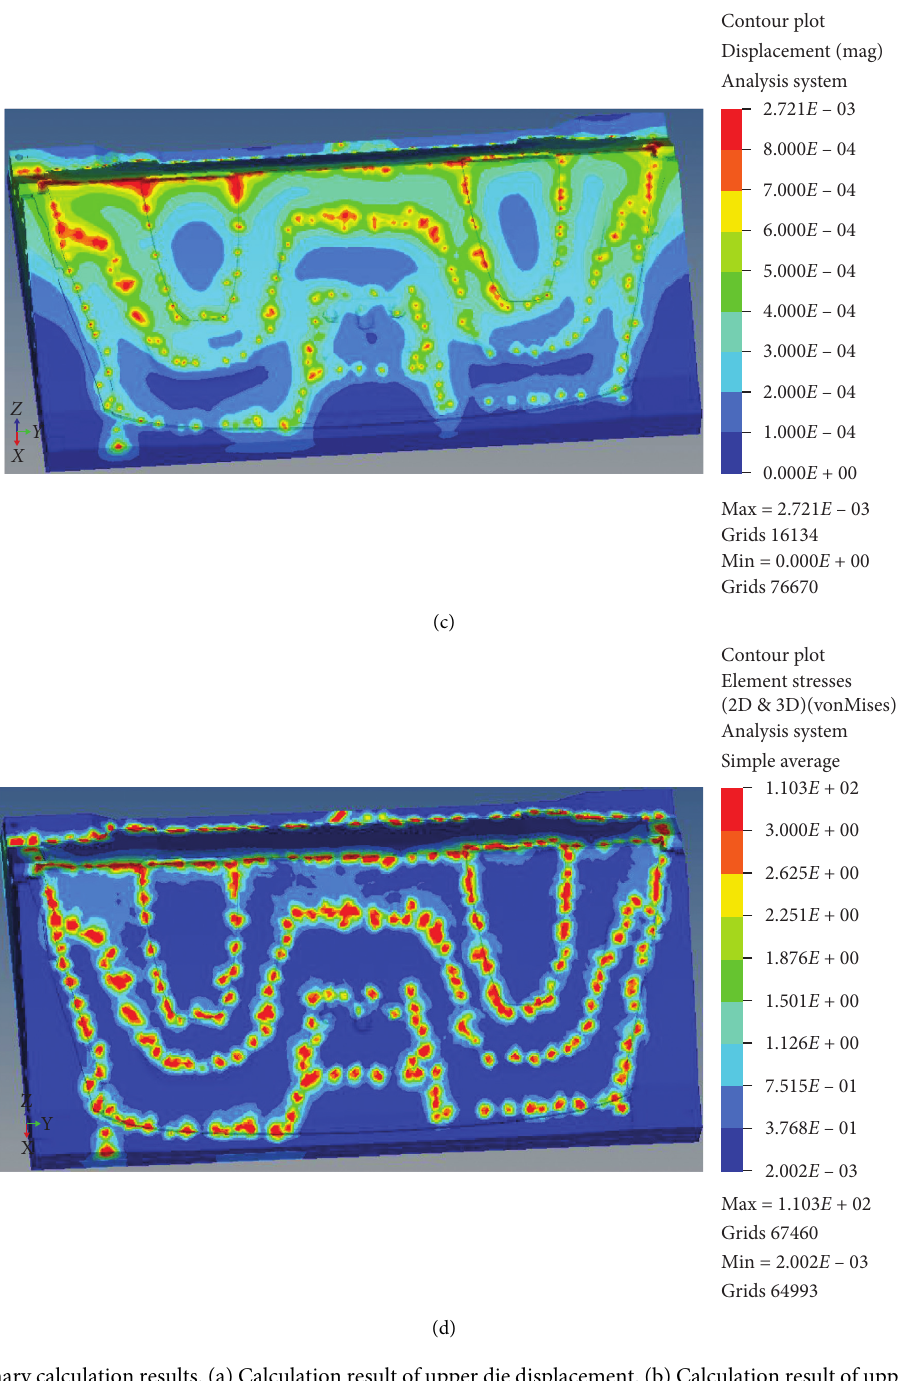
Figure 12: Preliminary calculation results. (a) Calculation result of upper die displacement. (b) Calculation result of upper mold equivalent stress. (c) Calculation result of lower die displacement. (d) Calculation result of equivalent stress of lower